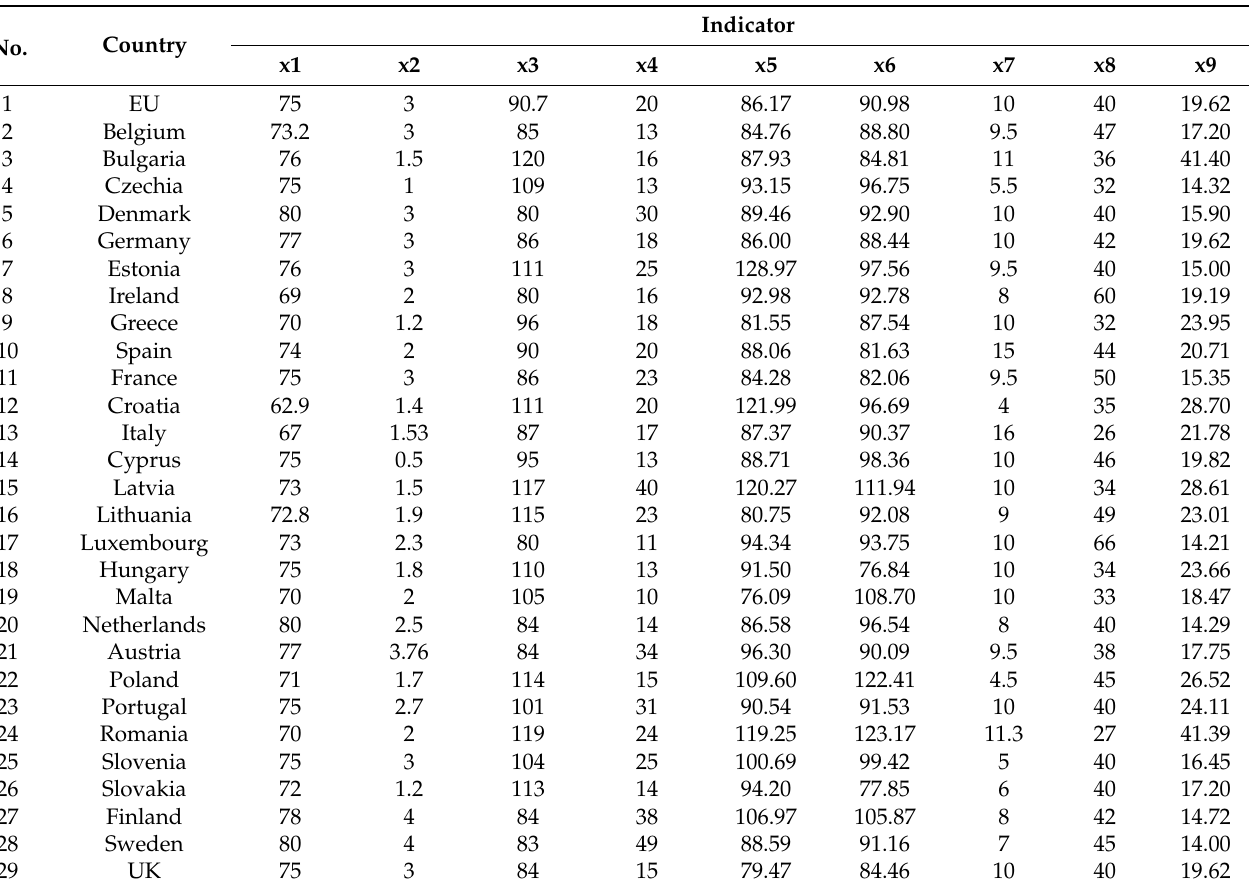
Table 3. The EU-level and national-level 2020